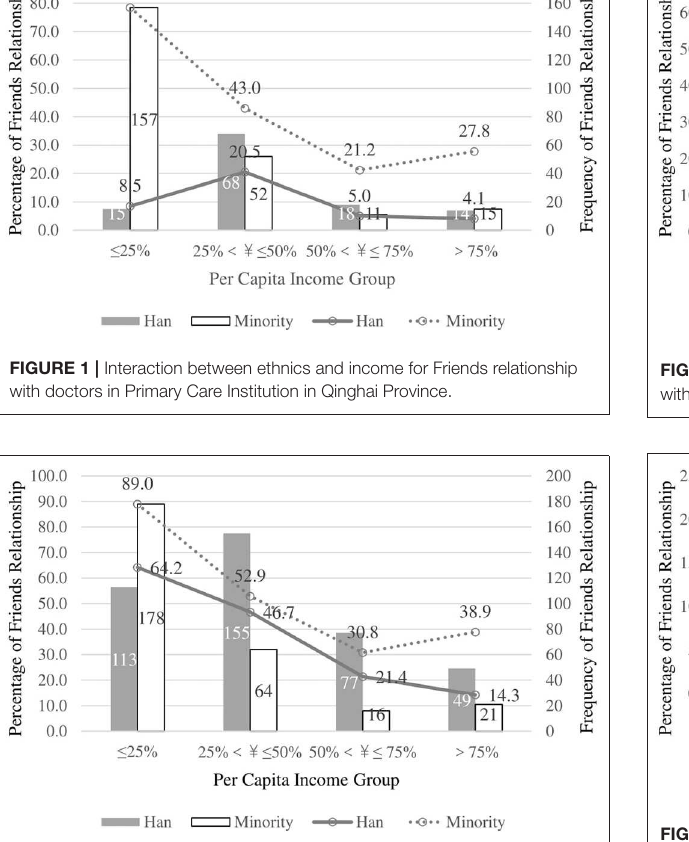
FIGURE 2 | Interaction between ethnics and income for Friends relationship with doctors in Big Hospitals in Qinghai Province.